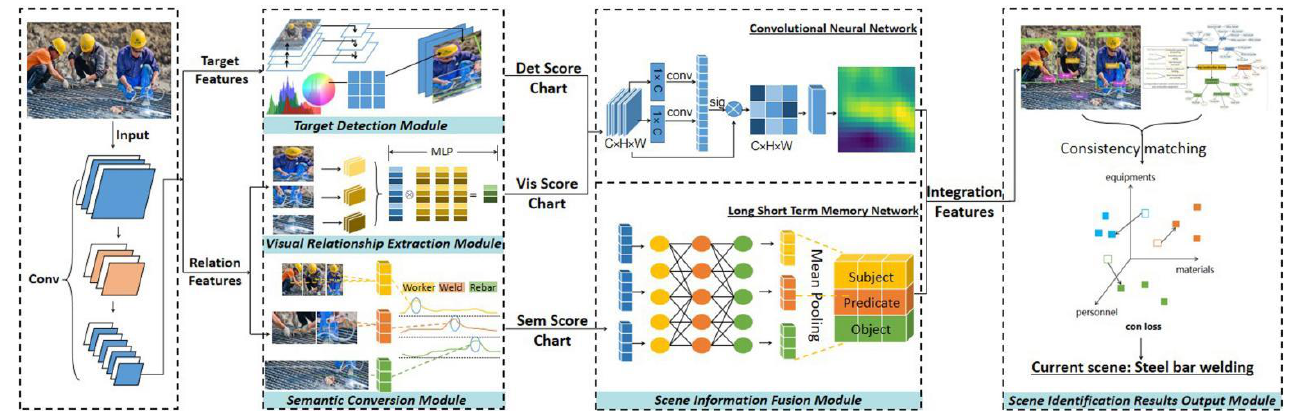
Figure 3. Structure schematic diagram of bridge construction scene identification model. (The source of the identifiable image in Figure 3 is shown in the Supplementary Materials) .